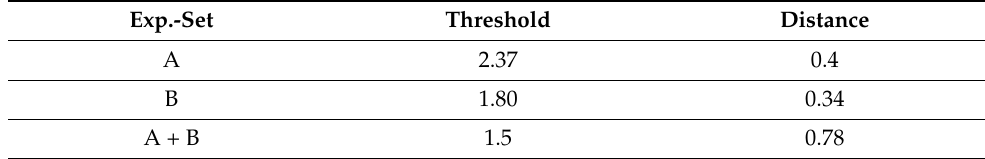
Table 2. Log thresholds and distances when integrating experiments for each